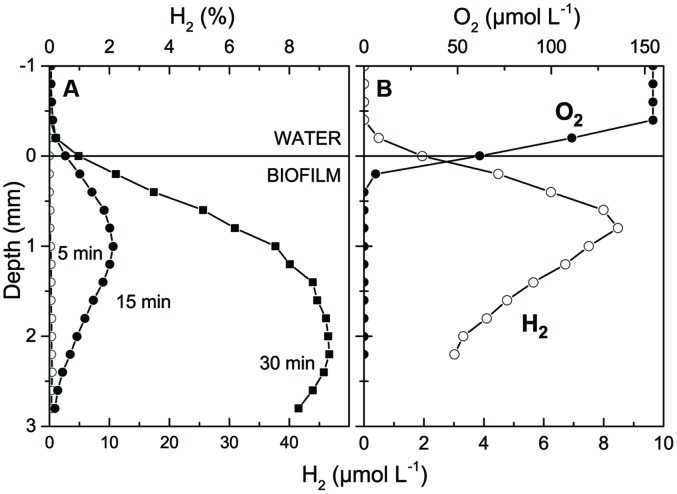
(A) Concentration profiles of H2 in a hypersaline microbial mat as a function of time after darkening. (B) Concentration profiles of H2 and O2 measured after 15 min darkness. The mat sample was incubated 2.5 h under a photon irradiance of 1800 μmol photons m-2 s-1 prior to darkening.